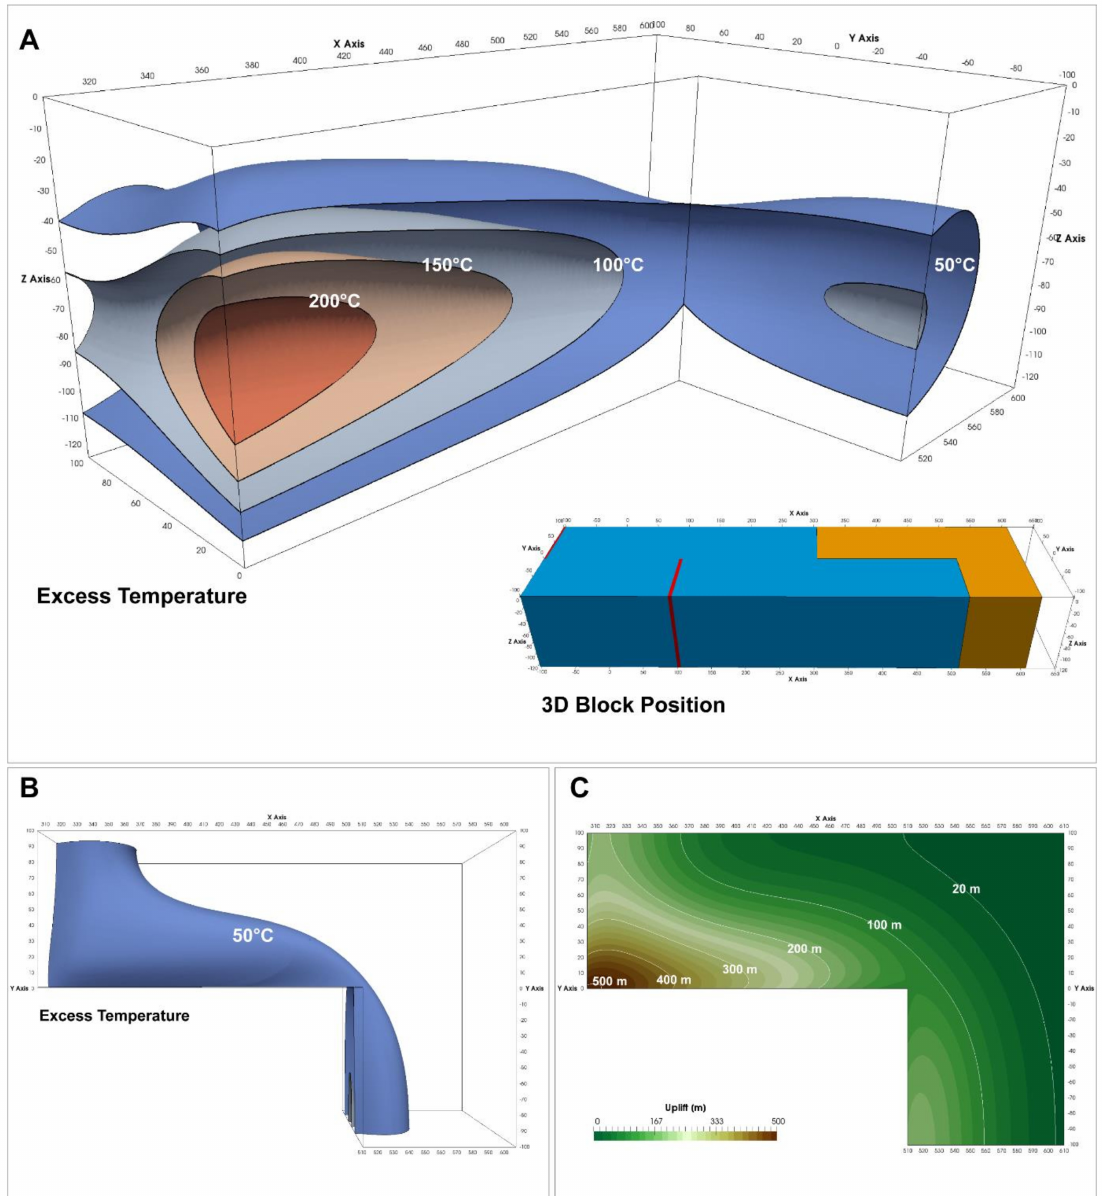
Figure 8. Thermal state of the continental block at the end of Stage B (40.5 Myr). ( A ) Side view of excess temperature contour surfaces within the continental lithosphere with a 50 ◦ C stepping. Inset shows the position of the 3D marker block. ( B ) Map view of the 50 ◦ C excess temperature contour surface. ( C ) Uplift experienced by the continental lithosphere at the end of Stage